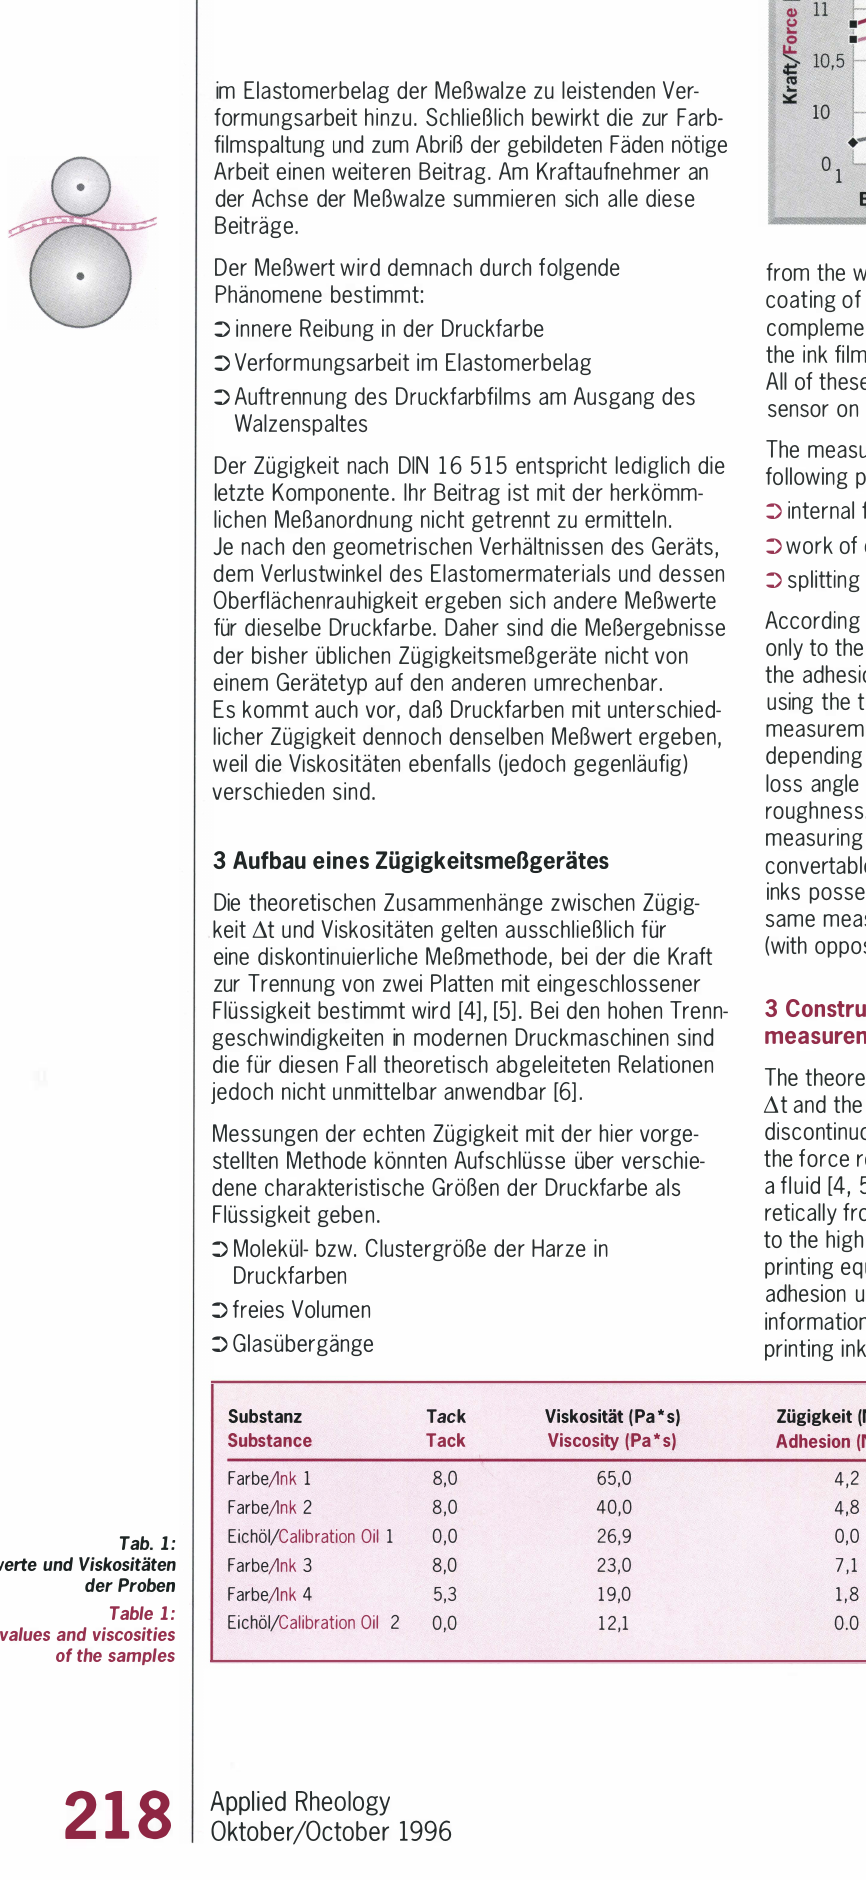
Figure 3: Speed dependence of the